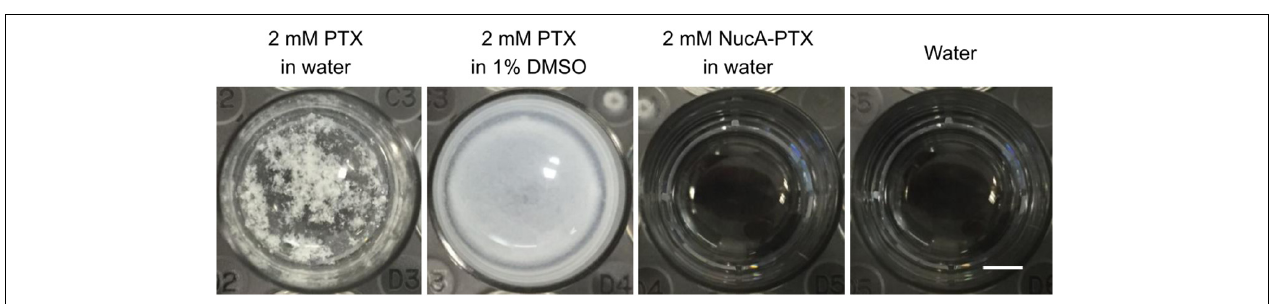
FIGURE 10 | The aqueous solubility of free PTX and the NucA–PTX conjugate. The scale bar indicated is 3 mm. Copyright from Zhang et al. (Li F. et al.,